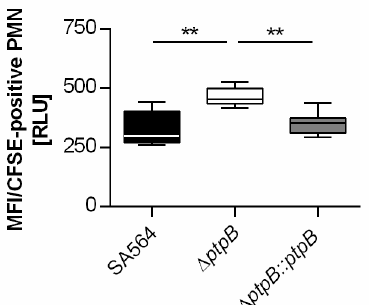
Figure 1. Effect of PtpB on phagocytosis of S. aureus SA564 by polymorphonuclear leukocytes (PMNs). Carboxy fluorescein diacetate succinimidyl ester (CFSE)-stained cells of S. aureus SA564 (black boxes), SA564 ∆ ptpB (white boxes), and SA564 ∆ ptpB::ptpB (gray boxes) were added to lithium heparin anticoagulated fresh human blood at a multiplicity of infection of 50 per PMN, and incubated for 30 min at 37 ◦ C and 1000 rpm. Attachment/uptake of bacteria by PMNs was analyzed by flow cytometry as outlined in Material and Methods. The data are representative of three biological replicates carried out in triplicate. Data are presented as box and whisker plots showing the interquartile range (25–75%; box), median (horizontal line), and whiskers (bars; min/max). ** p < 0.01 (Kruskal–Wallis test followed by Dunn’s post hoc